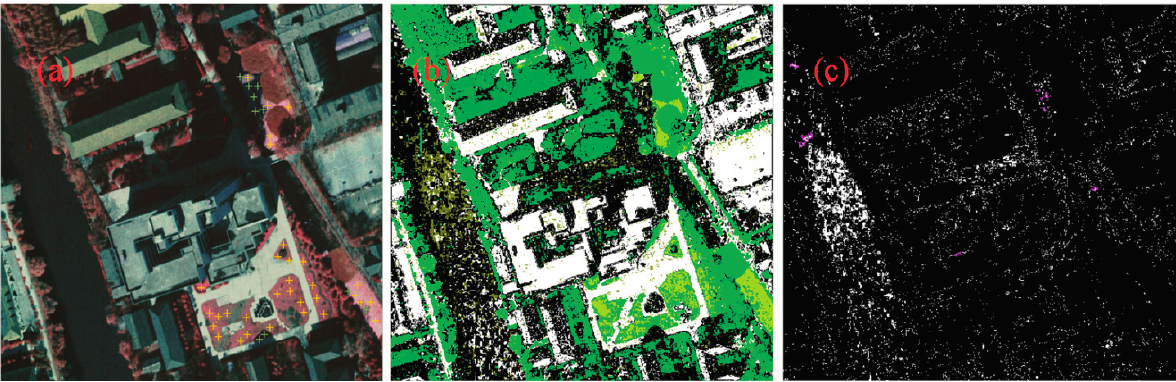
Figure 4. Readjusting members by the member-level spatial analysis. (a ) Original image and the samples of sunlit grass (apricot cross) and shaded grass (olive-green cross); ( b ) originally classified members; and ( c ) originally classified shaded grass members (white patches) and ensured ones (magenta sketched). It can be seen that the once poor separability between shaded grass and dark background members has been improved by using the inter - member dependency rule .